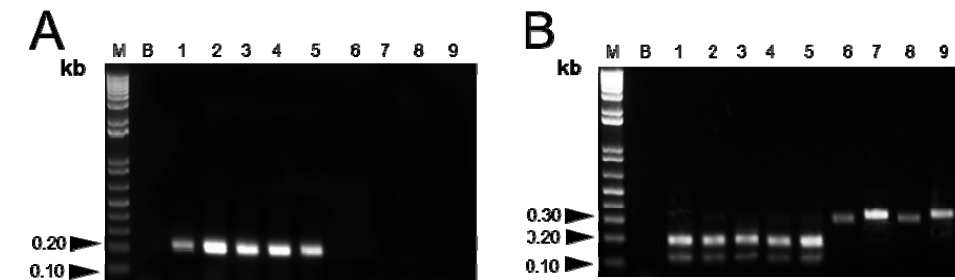
Figure 4. ( A ) PCR amplification of nine commercially available crude drugs of Bulbus Fritillariae Cirrhosae using SCAR marker amplification (CBM-S and CBM-AS); A specific band (231 bp) for Bulbus Fritillariae Cirrhosae was detected in samples 1–5. ( B ) PCR-RFLP analysis of Bulbus Fritillariae Cirrhosae validated results obtained using the SCAR marker. The detail protocol was displayed in part 3.8 . The five samples generated two fragments between 100–200 bp after being digested by SmaI , confirming that they were Bulbus Fritillariae Cirrhosae ( B